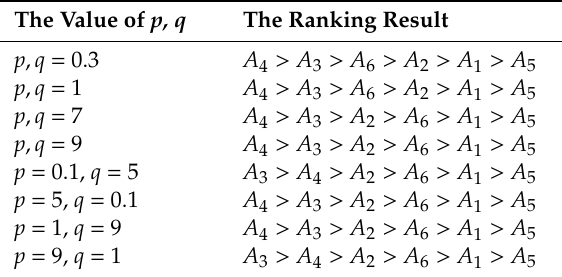
Table 3. The impact of parameters p ,